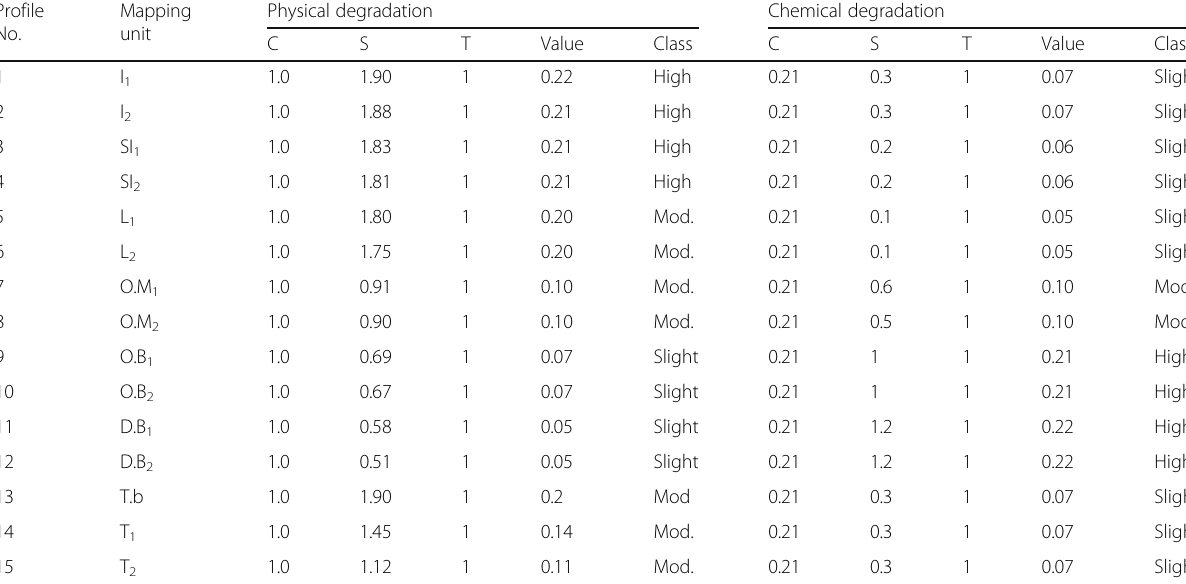
Table 7 Physical and chemical degradation classes according to the natural factors Profile